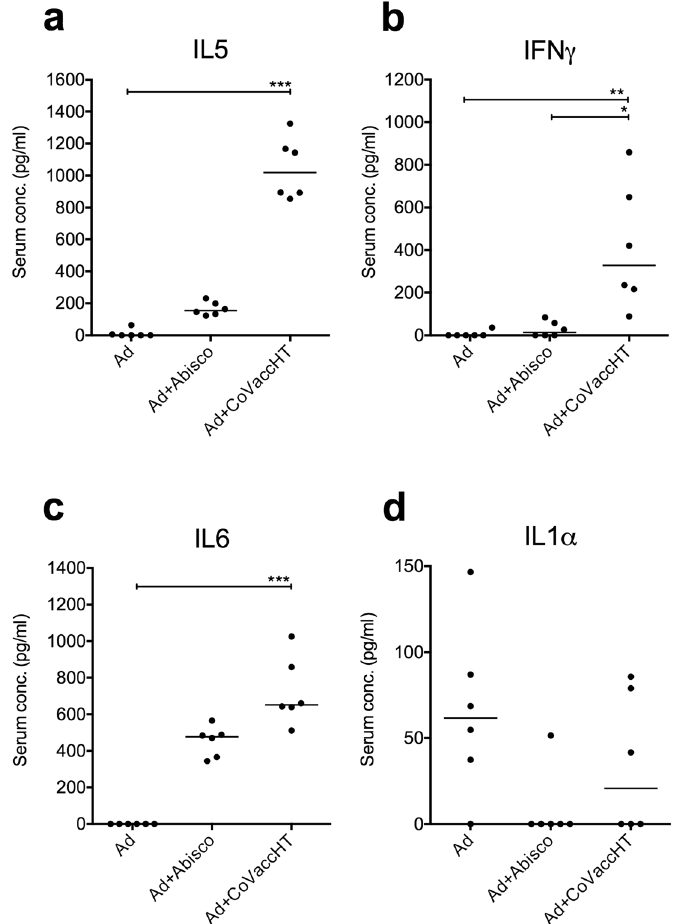
Figure 3. Analysis of serum cytokine levels in vaccinated animals. Serum samples from BALB/c mice (n = 6), vaccinated with Ad-ME.TRAP (5 × 10 9 vp/dose) alone or adjuvanted with Abisco ® -100 or CoVaccineHT, were collected at days 1, 7 and 14 post- immunisatiosn. Serum cytokine levels were measured using Th1/Th2/Th17/ Th22 13-plex mouse multiplex bead array kit with added IL-1 β . A number of cytokines could not be detected at any of the above time-points. Data are shown for cytokines that had differential levels of expression among the different experimental groups at day 1. Statistical analysis was carried out using ranked one-way ANOVA analysis (Kruskal-Wallis) with Dunn’s test for multiple comparisons; * p < 0.05, ** p < 0.01, *** p < 0.001. Data from all three time-points for the detected cytokines are shown in the Supplementary Figure